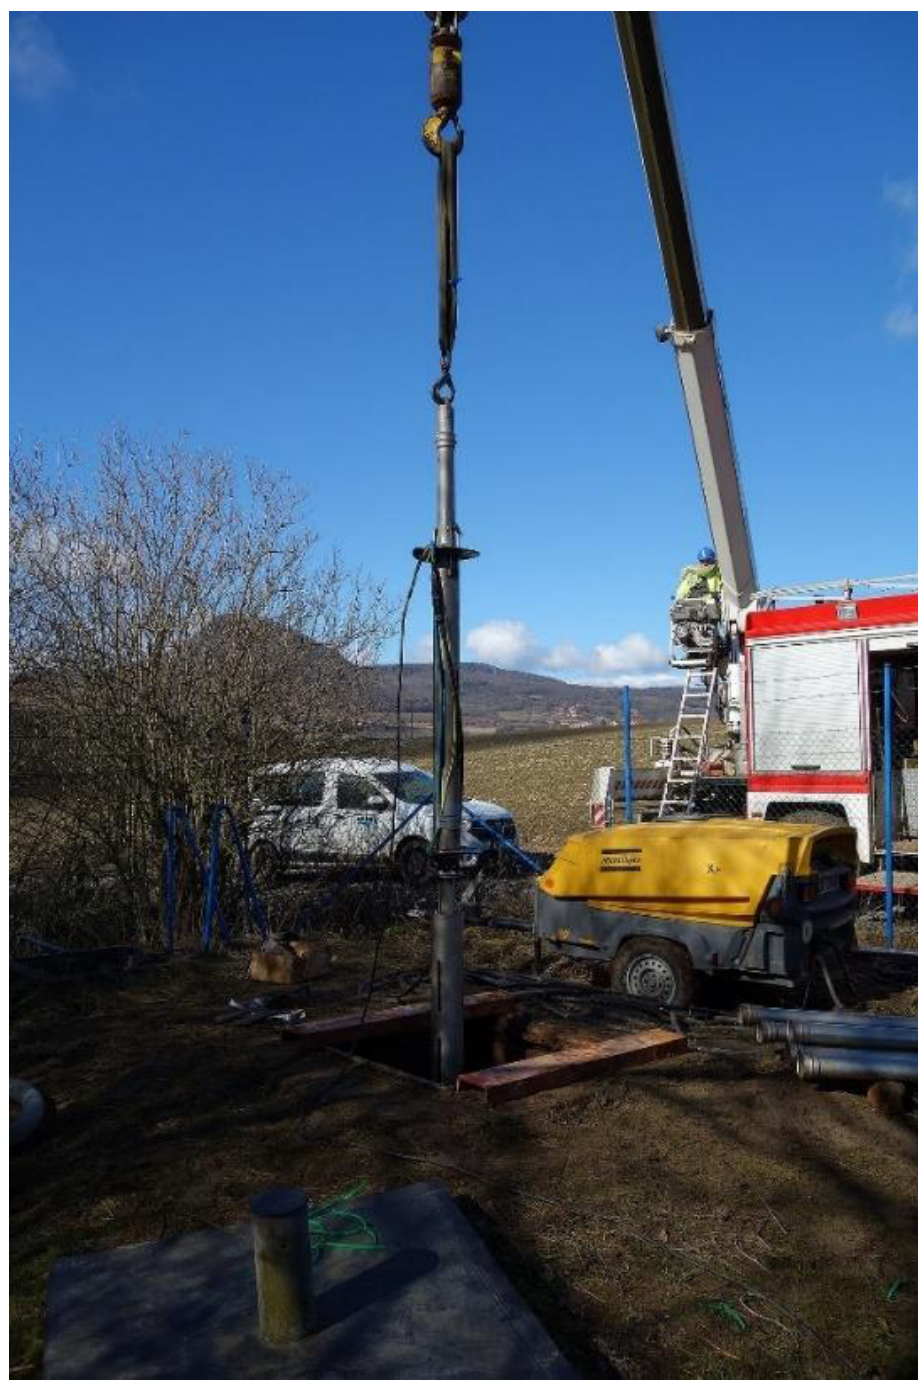
Figure 7. Rehabilitation set built within the project. Finally, a second air-lift pump was deployed to remove the residual sediments and those induced by ultrasound. A comparison of the conditions inside the well before and after rehabilitation at different depths is shown in Figure 8. A 3Dgeo color PAL-format immersion camera with a resolution of 750 × 600 (96 dpi) was used to capture images of the site.